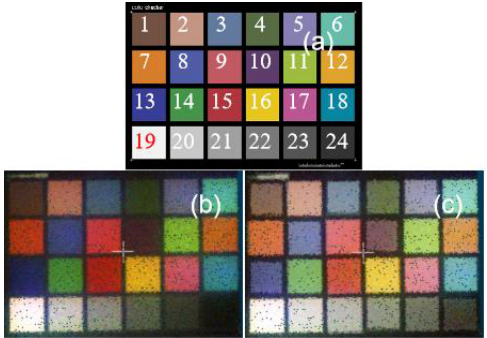
Figure 11. ( a ) The color checker. ( b ) Point cloud colored using Gaussian area with 5-pulse accumulation. Figure 11. (a) The color checker. (b) Point cloud colored using Gaussian area with 5-pulse 411 ( c ) Point cloud colored using lognormal area with 5-pulse accumulation. (c) Point cloud colored using lognormal area with 5-pulse accumulation. 412